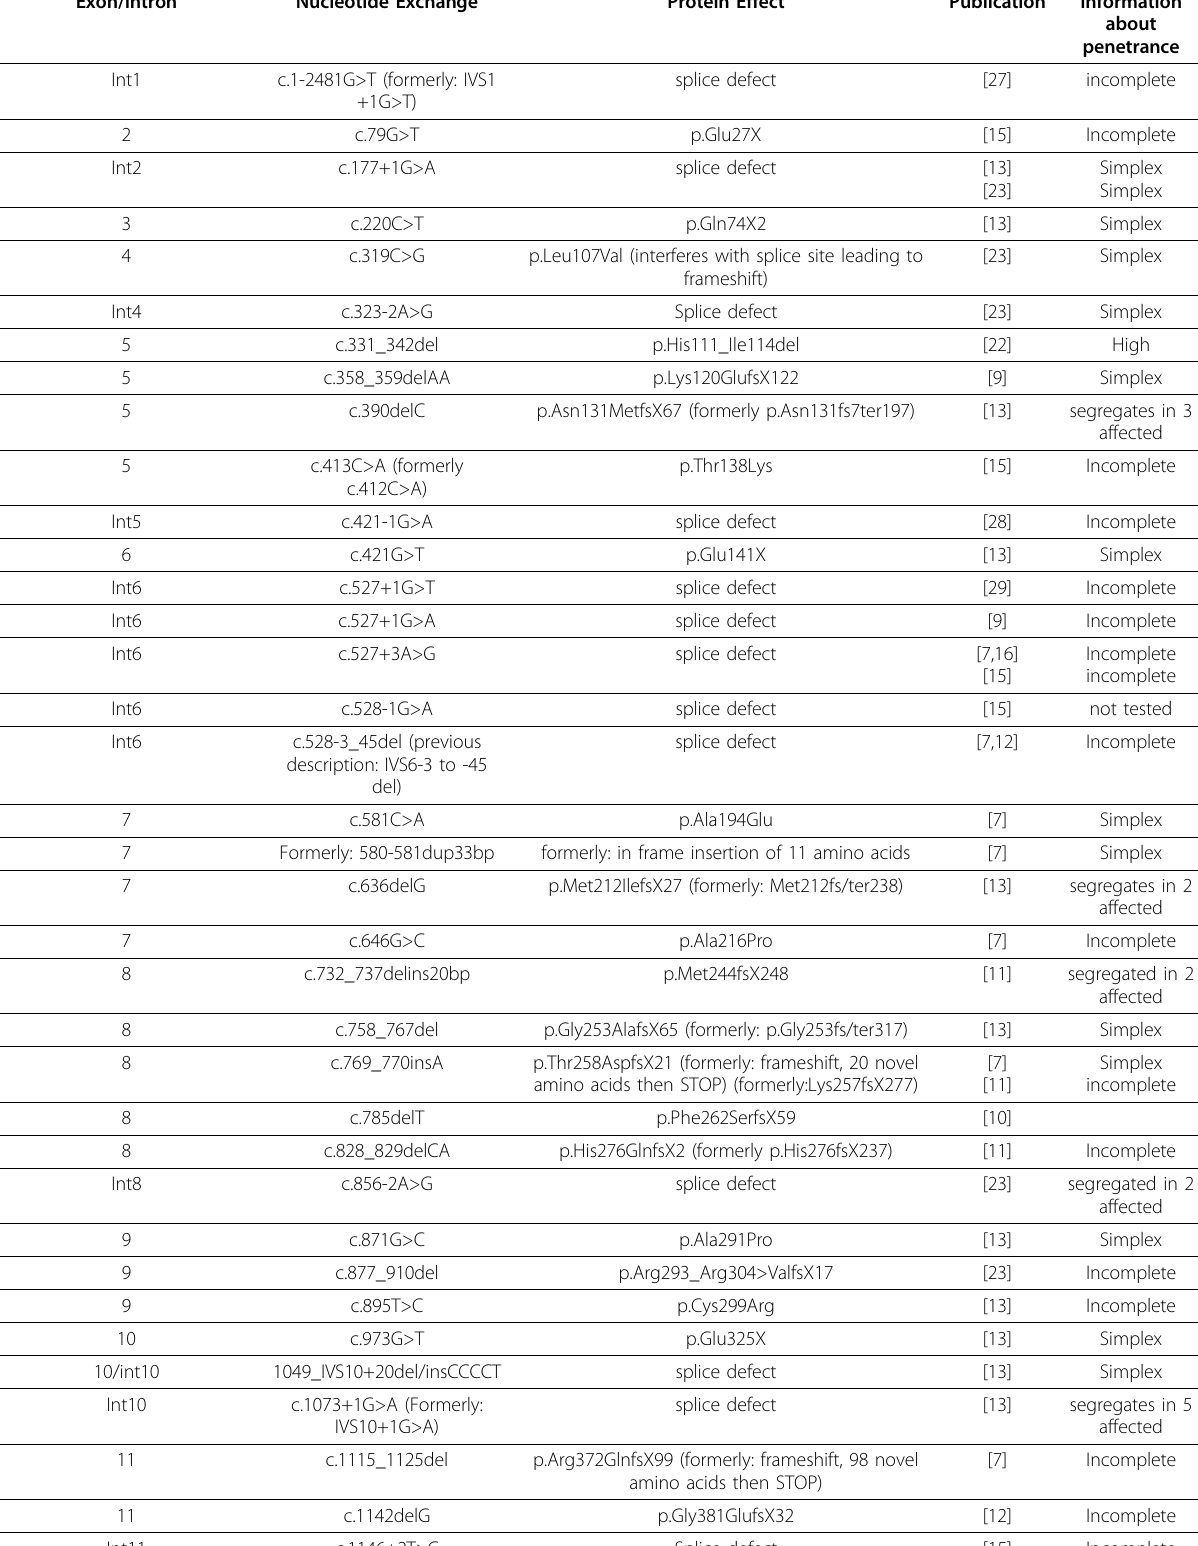
Table 1 Previously described PRPF31 mutations in adRP